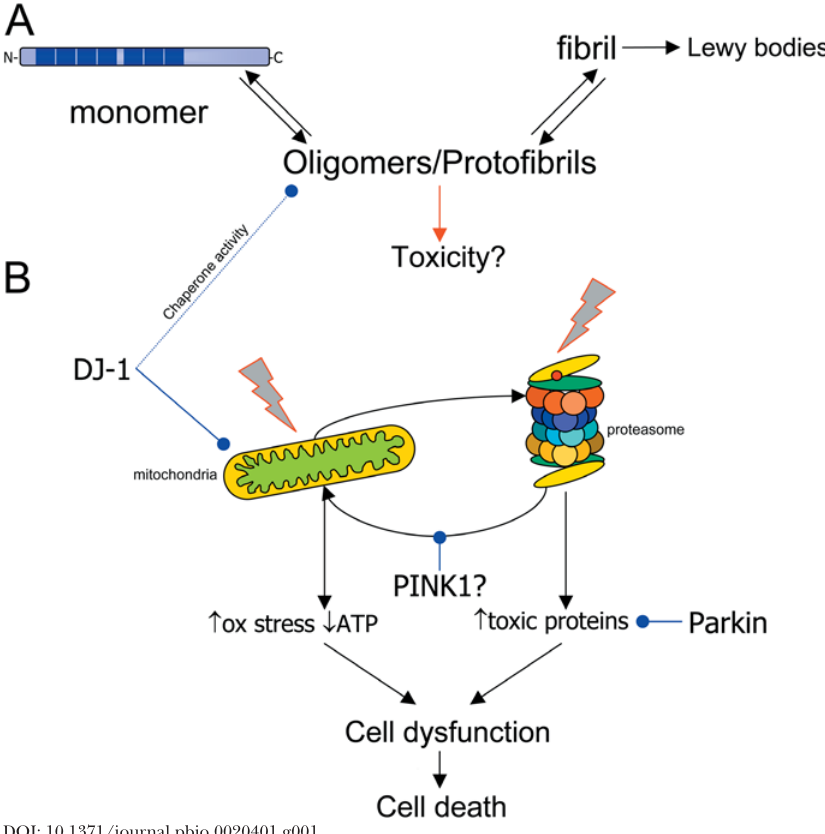
Figure 1. Molecules That Cause or Prevent Parkinson’s Disease (A) shows a simplifi ed, linear view of the aggregation pathway of α-synuclein (in blue). The monomer of α-synuclein is a natively unfolded protein with several repeats, shown by dark bars on the monomer. The protein has an innate tendency to aggregate with other molecules of α-synuclein, fi rst into oligomers (also known as protofi brils), then into fi brils. It is the fi brillar forms of α-synuclein that are deposited into the classic pathological structures of PD, Lewy bodies. There are several studies that suggest that the oligomeric intermediates are the major toxic species, although this is not certain. (B) shows the recessive mutations associated with parkinsonism and their possible relationships to subcellular targets, either mitochondria (left) or the proteasome (right). Insults to either of these can cause cellular damage and may interact. For example, proteasome inhibitors can cause mitochondrial damage, which can be antagonized by PINK1. Parkin can promote the turnover of proteasomal substrates, and DJ-1 can prevent mitochondrial damage. Quite whether (B) relates to (A) is not clear, but recent results with DJ-1 imply that DJ- 1 has chaperone activity towards oligomers of α-synuclein (see text). Although there is much to be done to resolve the order of these events, it is likely that, either alone or in concert, damage to multiple cellular pathways leads to neuronal dysfunction and, eventually, cell